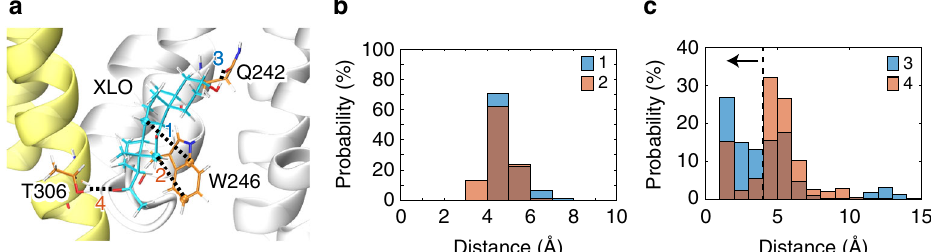
Fig. 5 Alphaxalone interactions with nearby residues in molecular dynamics (MD) simulations. a A representative snapshot from MD simulations shows alphaxalone contacts with T306, Q242, and W246. Distances between alphaxalone and the residues are measured as marked by the dash lines. b Histograms of distances between alphaxalone and W246 atoms (1 and 2) shown in a . c Histograms of distances between alphaxalone and Q242 or T306 atoms (3 and 4, respectively) shown in a . Data in b and c are from three replicate 50-ns simulations, where snapshots were collected every 100-ps for analysis. Distances were measured for each of the fi ve alphaxalone molecules per replicate simulation (500 snapshots × 3 replicates × 5 alphaxalone = 7500 distances in total)